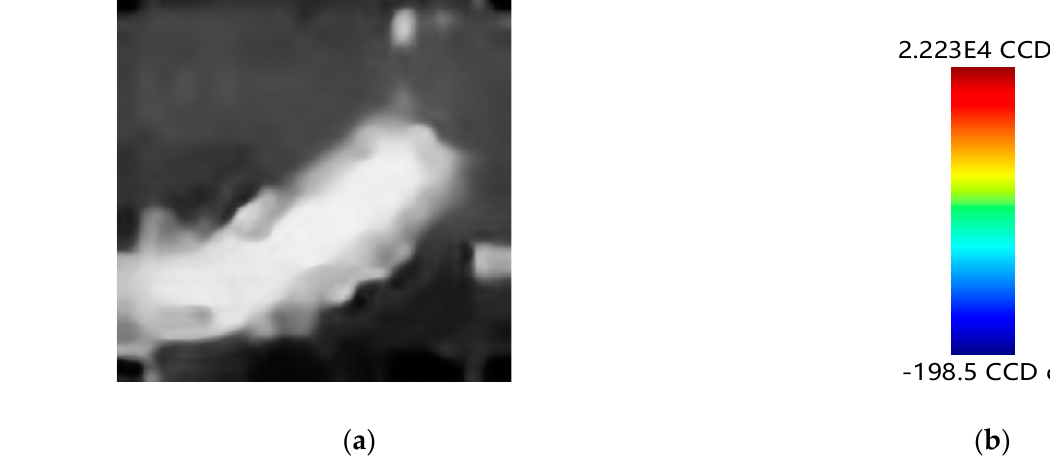
Figure 14. ( a ) The grayscale image after interpolation and super-resolution. ( b ) Pseudo-color index